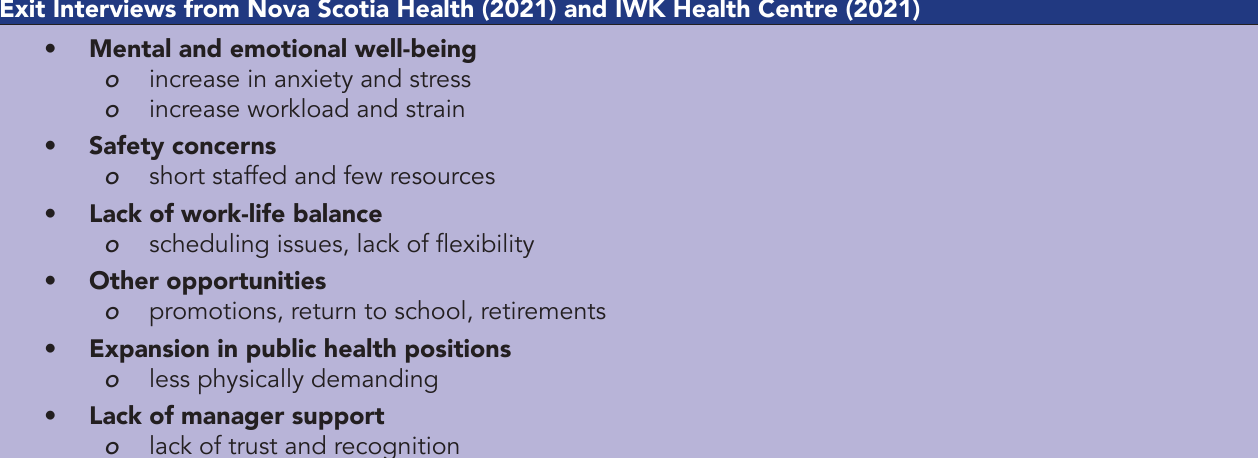
Table 11: Contributing factors to nurses leaving their positions or organizations in Nova Scotia Exit Interviews from Nova Scotia Health (2021) and IWK Health Centre